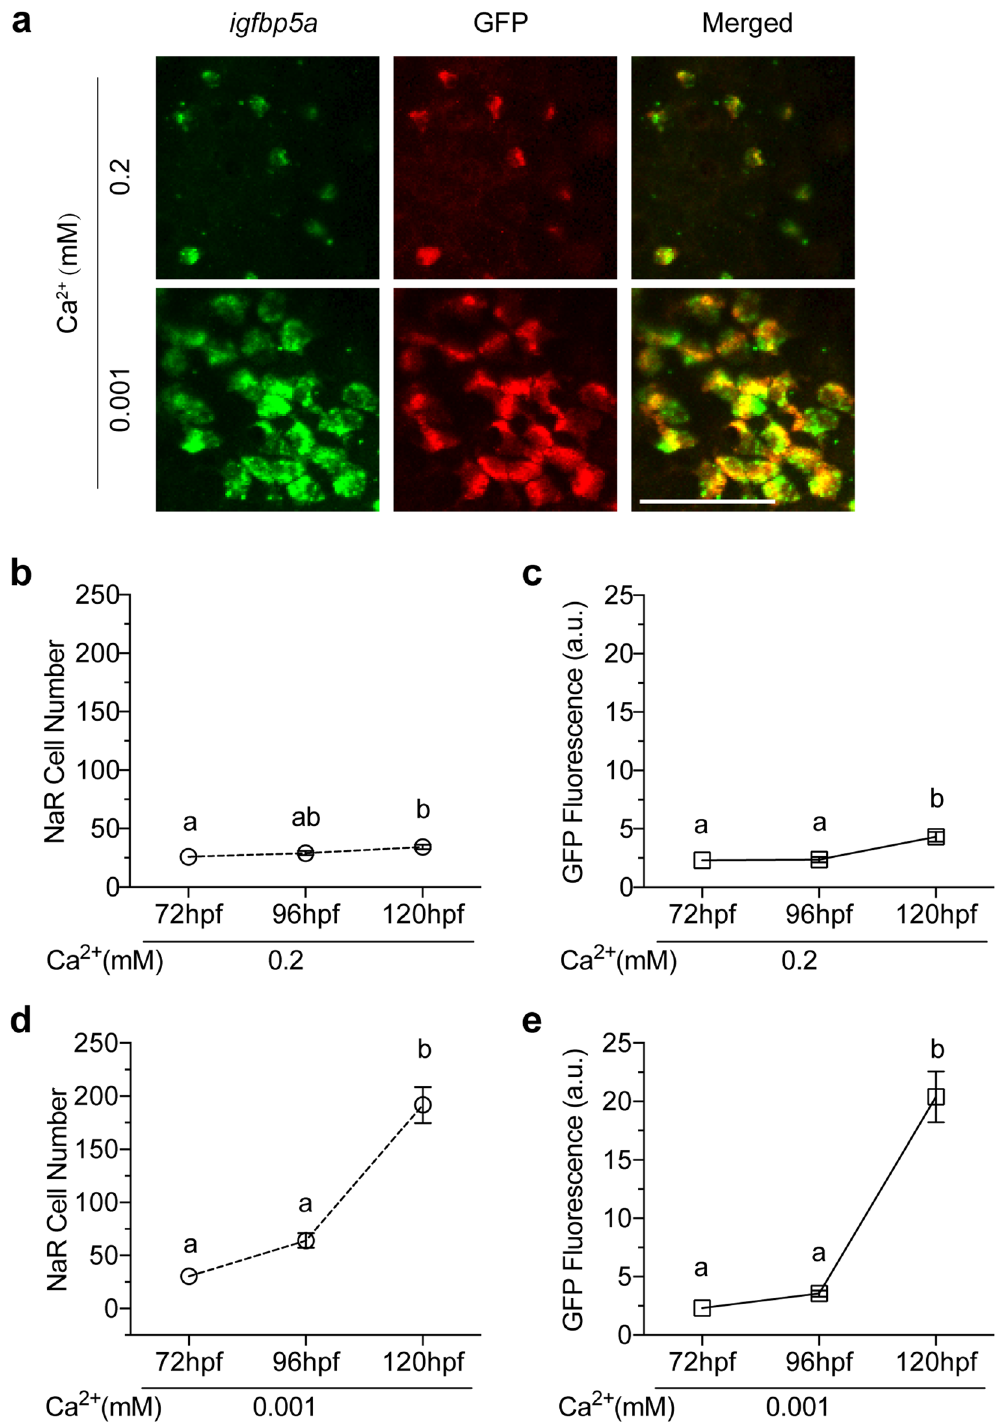
Figure 4. Tg ( igfbp5a : GFP ) fish faithfully recapitulates low [Ca 2 + ] stress-induced NaR cell proliferation. ( a ) The GFP transgene is specifically expressed in NaR cells. Tg ( igfbp5a : GFP ) larvae (72 hpf) were transferred to embryo rearing solution containing the indicated [Ca 2 + ]. 48 hours later, they were analyzed by in situ hybridization for igfbp5a mRNA expression (green, left panels) and GFP immunostaining (red, middle panel). Merged views are shown in the right panels. Scale bar = 50 μ m. ( b , c ) Changes in NaR cell number (b) and GFP fluorescence intensity (c) under normal [Ca 2 + ] at the indicated time points. Values shown are mean ± SEM. n = 7. Different letters indicate significant differences at p < 0.05. ( d , e) Changes in NaR cell number (d) and GFP fluorescence intensity (e) under low [Ca 2 + ] at the indicated time points. Values shown are mean ± SEM. n = 11. Different letters indicate significant differences at p <